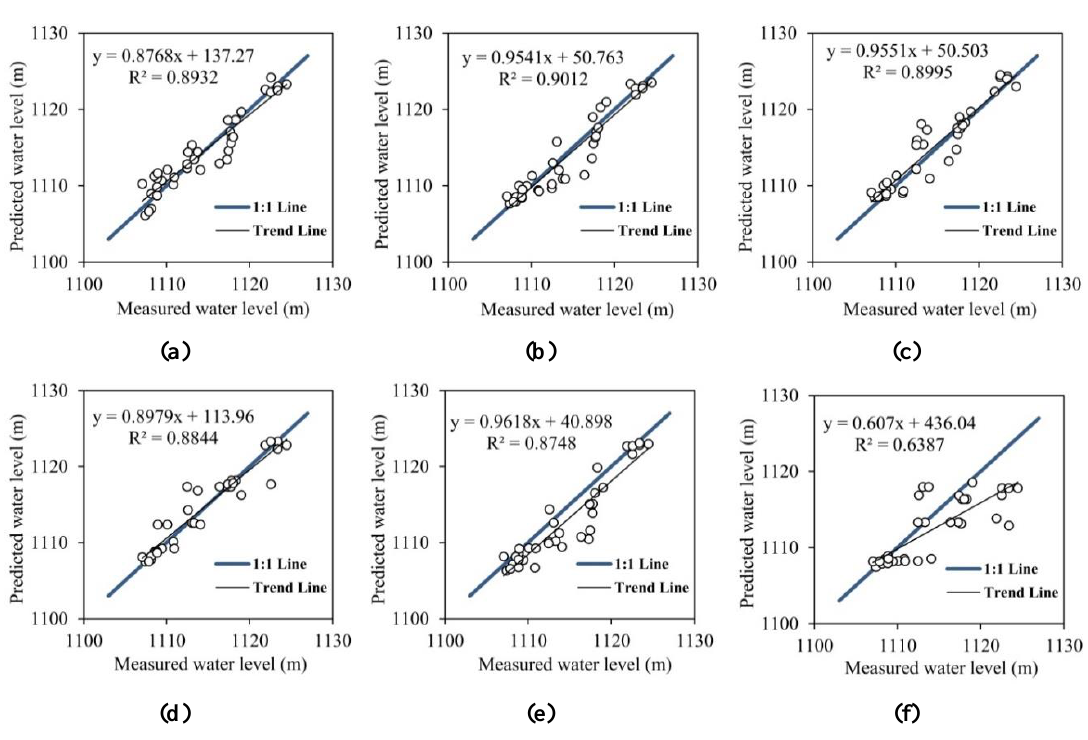
Figure 8. Results obtained from data-driven models in test stage for simulating piezometer 30 level variations; (a) MLR, (b) ANN-HS, (c) ANN-PSO, (d) RDT, (e) ANN-LM, (f)